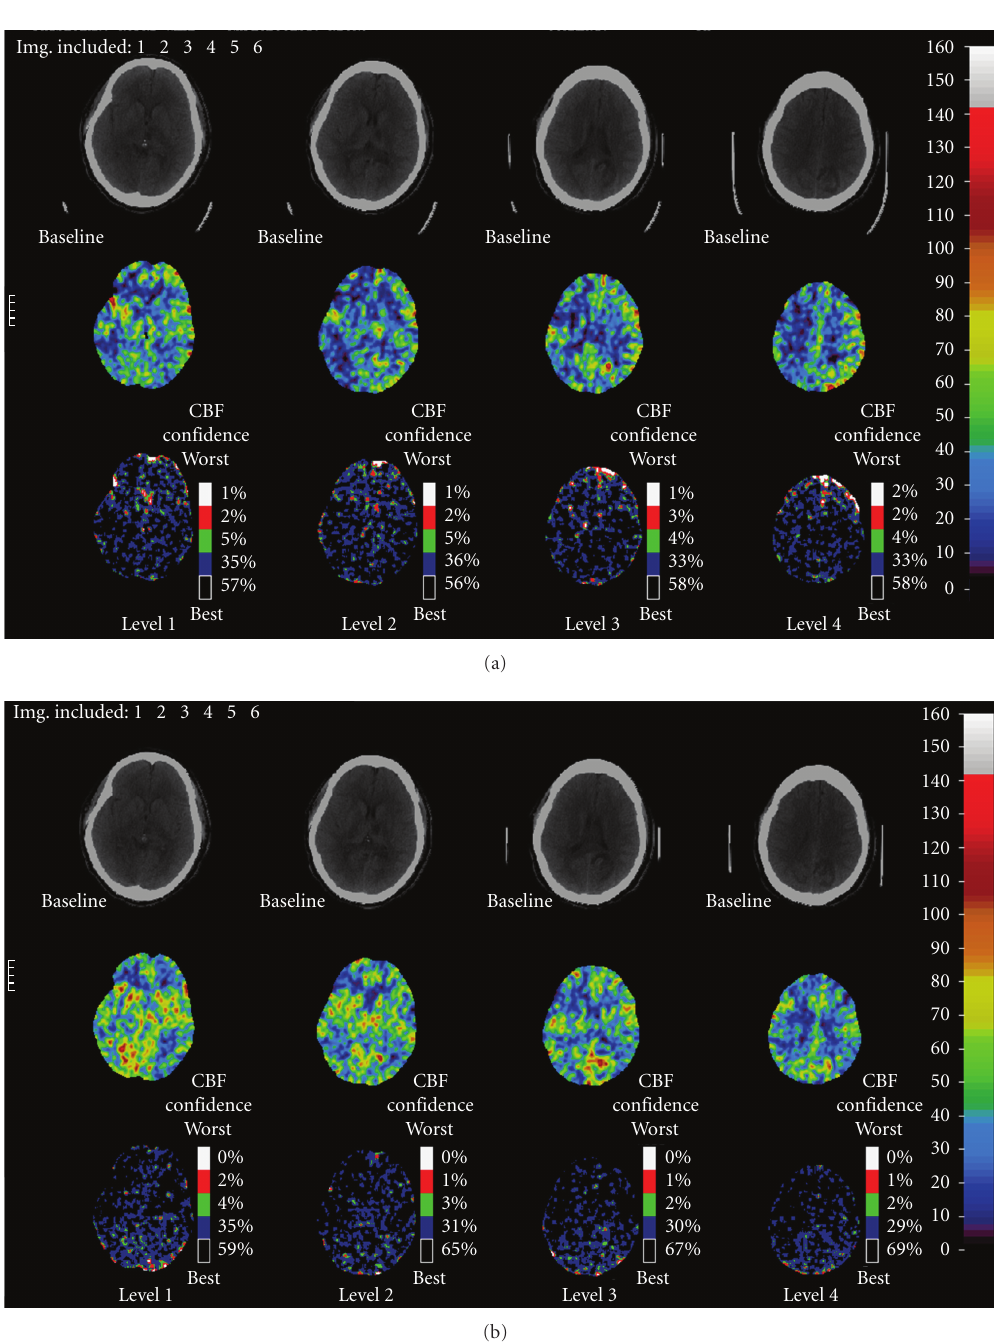
Figure 4: (a) Baseline Xenon perfusion study (SBP 120 mm Hg) demonstrates decreased cerebral blood flow (CBF) in both posterior cerebral artery (PCA) territories as well as in the right middle cerebral artery (MCA) and left anterior cerebral artery(ACA) territories. (b) With elevation of SBP (130mm Hg), there is improvement in CBF in the right parietal region, but no significant improvement in the left PCA territory. There is increased perfusion in the right MCA and left ACA distributions. Increased perfusion is seen within the right occipital and left parietal lobe